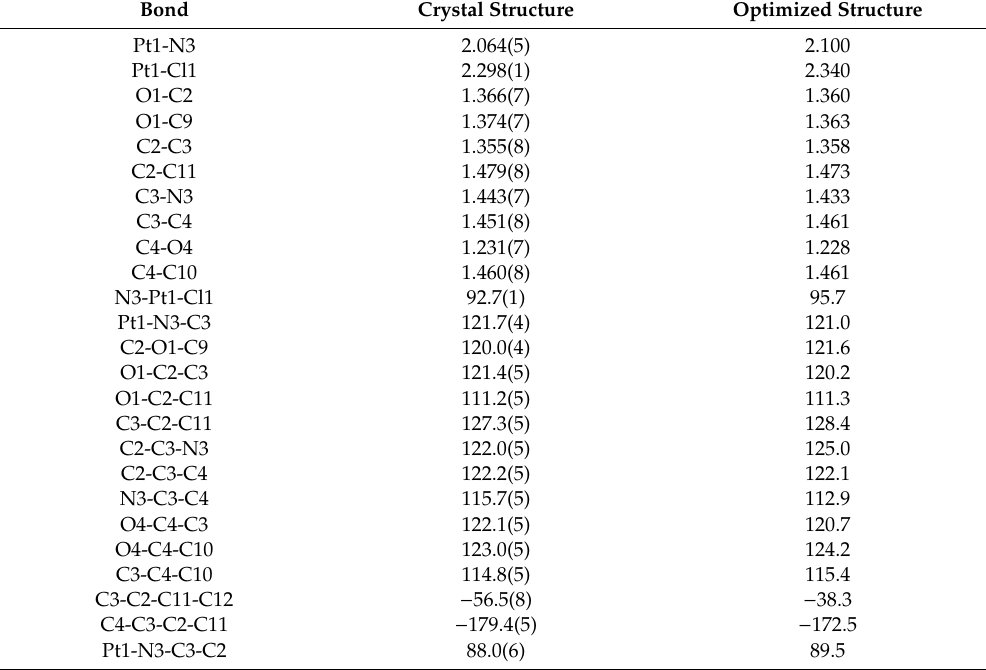
Table 2. Comparison of selected intramolecular bond lengths (in Å) and angles (in degrees) of trans –Pt(3-af) 2 Cl 2 complex. Bond Crystal Structure Optimized